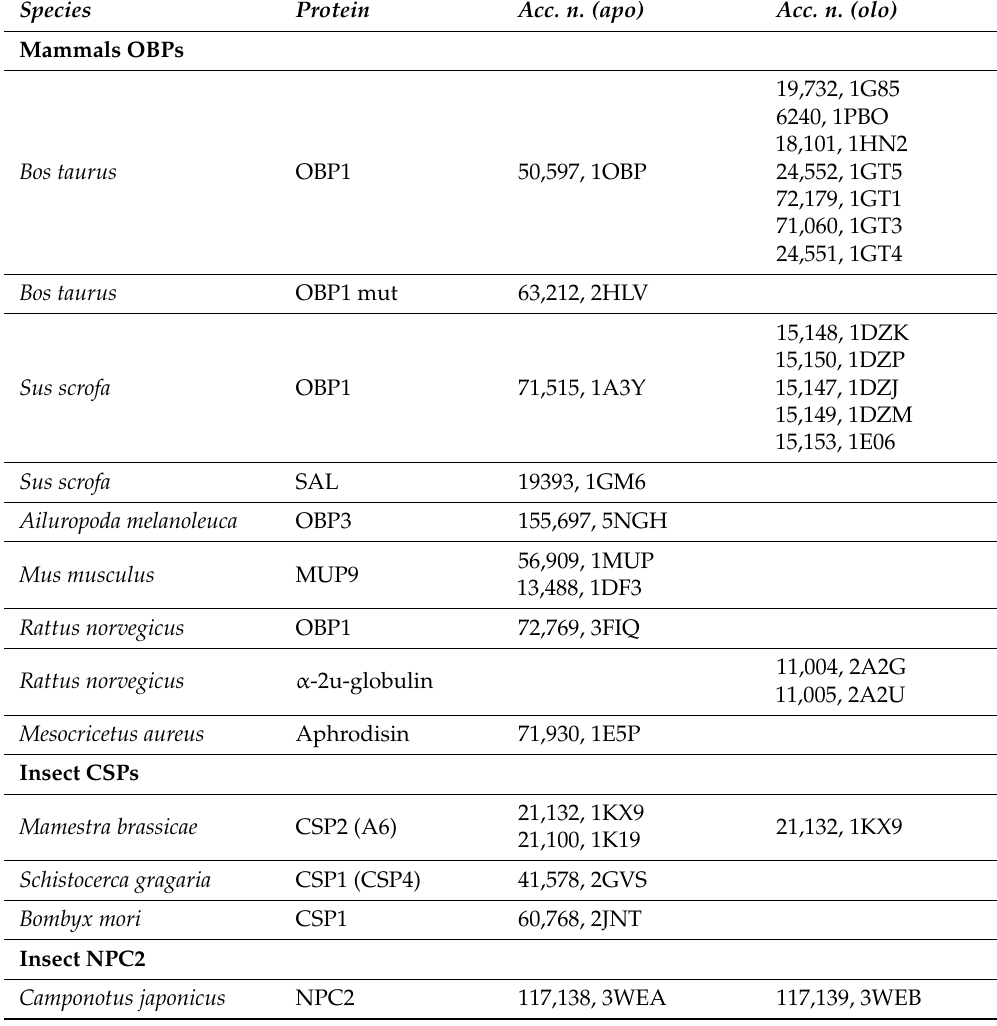
Table 3. Structures of mammals OBPs, and insect CSPs and NPC2. Accession numbers